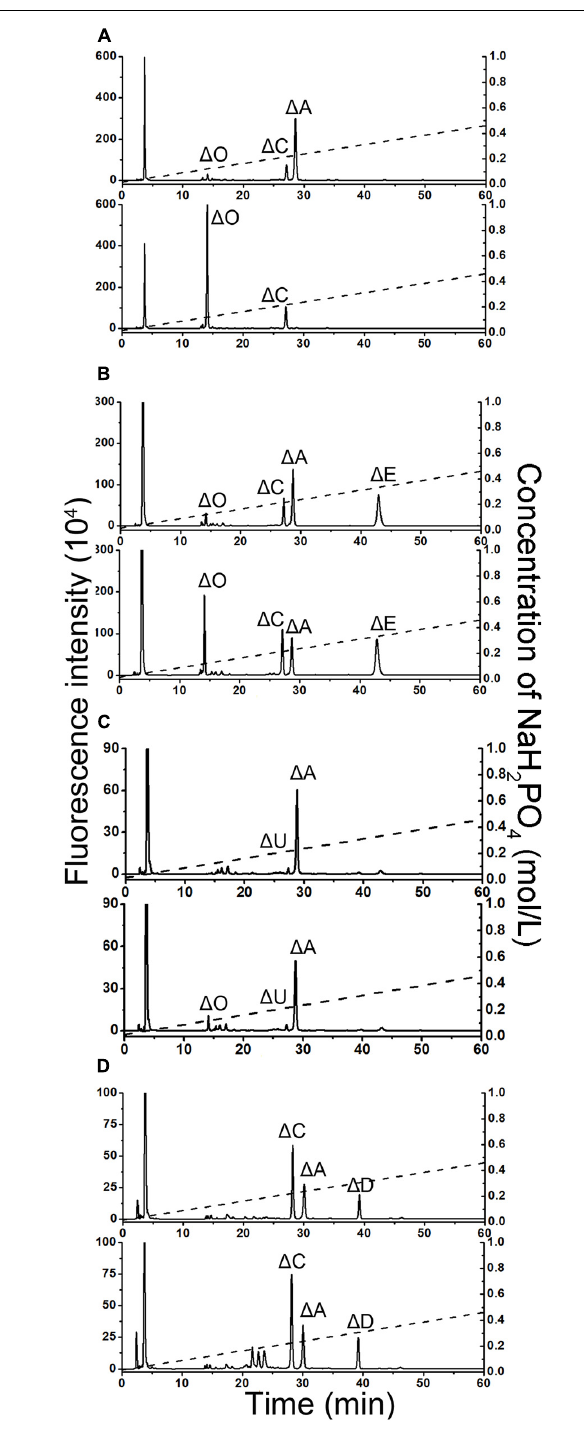
FIGURE 6 | Disaccharide analysis of various 4- O -sulfated or 6- O -sulfated CS tools for editing the sulfation patterns of CS/DS chains in related polysaccharides treated with PB_3262 and PB_3285. Three types of structure-function studies and oligosaccharide 4- O -sulfate-containing polysaccharides CS-A (A) , CS-E (B), and DS (C) were hydrolyzed without (top) or with (bottom) PB_3262 at 25 ◦ C for 12 h as described in section “Materials and Methods,” and the 6- O -sulfate-containing polysaccharide CS-C (D) was treated without (top) or with (bottom) PB_3285 (Continued)